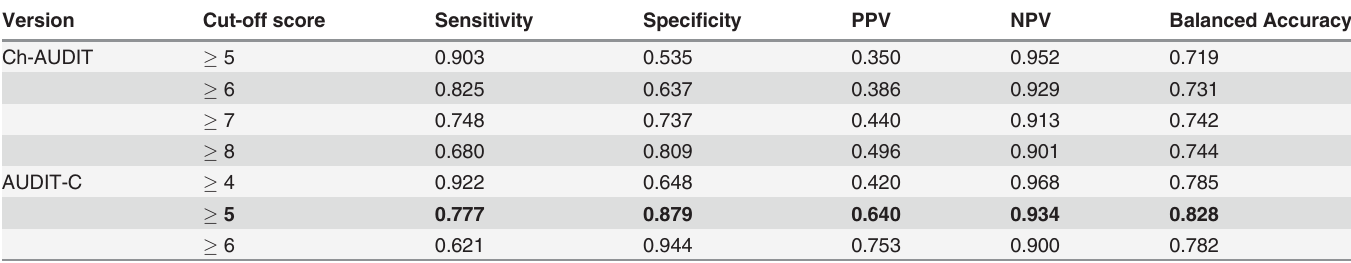
Table 3. Diagnostic accuracy of Ch-AUDIT and AUDIT-C across different cut off scores for screening of risky drinking behavior among male patients in primary care setting. Version